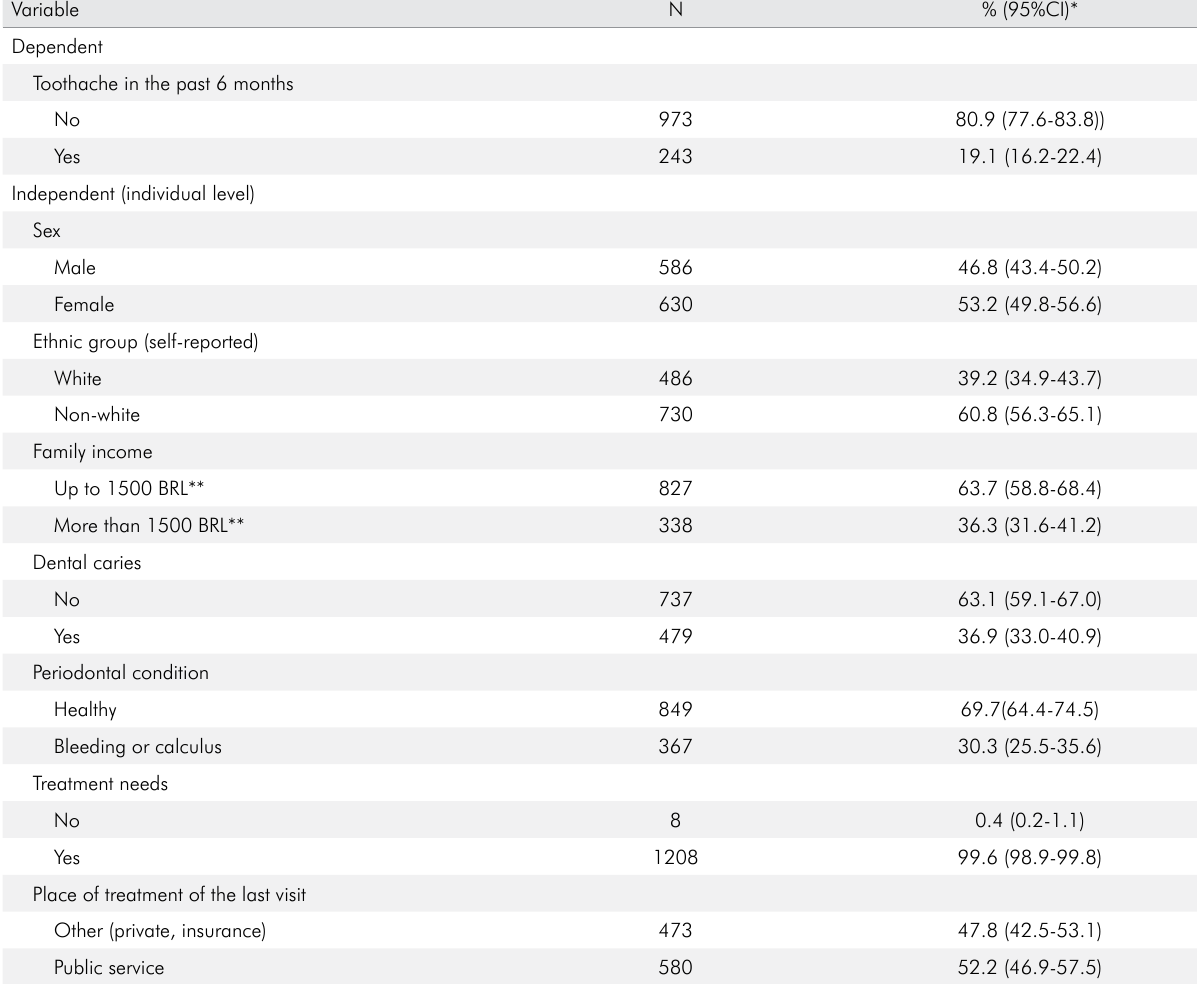
Table 2. Descriptive analysis of individual variables of adolescents (12 years old) from a southeastern state of Brazil, 2012